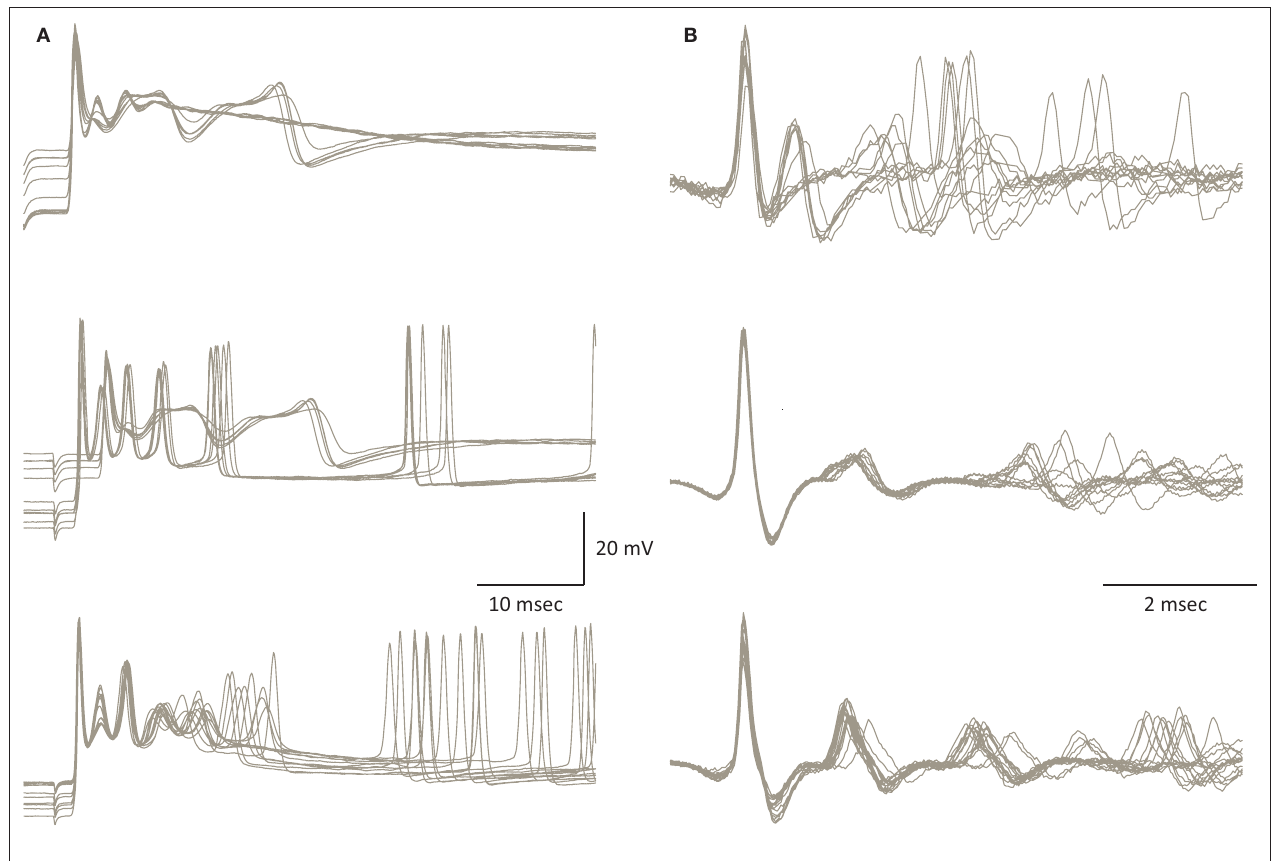
of the CSs. (B) Examples of spontaneously occurring CSs recorded from 3 PC in anesthetized rats. Note the limited variability of the initial part of the waveform as opposed to the extensive variations in the late wavelets (fi gure modifi ed from Tal et al.,